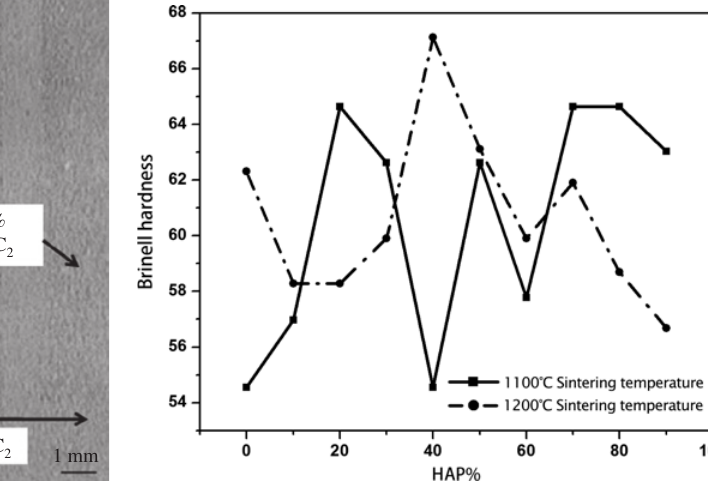
Figure 10: Optical micrograph of polished Al